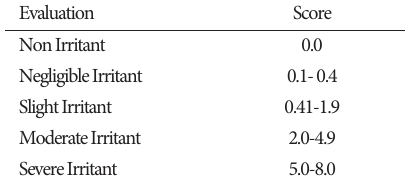
Table 3. Evaluation of primary skin irritation index